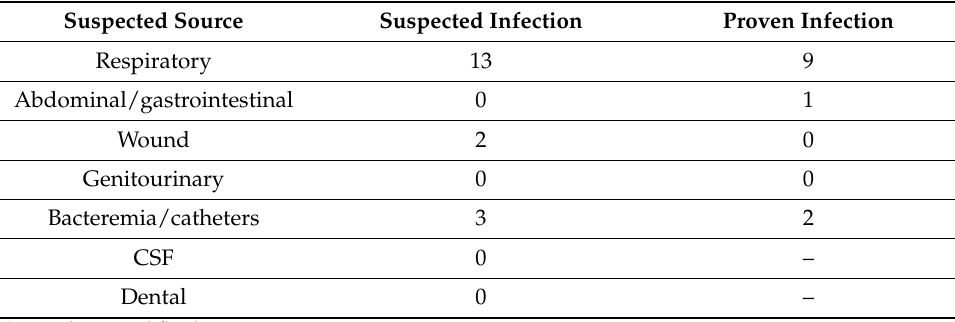
Table 2. Suspected or proven sources of infection in those diagnosed with